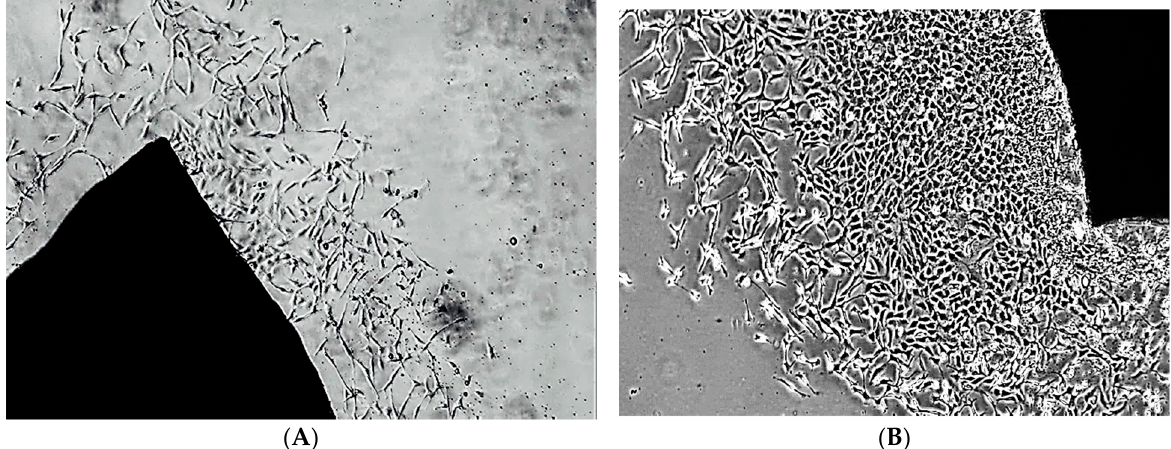
Figure A1. In vitro culture of rat aortic VSMCs from aortic explants viewed at 160× magnification (10× E-PL, 4× objective lens, 40× image magnification) under an inverted Olympus light microscope. ( A ) Cell growth after 4 days incubation; ( B ) cell growth after 7 days incubation (scale bar: 27.2851 µM). Figure A2 is a visual presentation of the stained rat aortic VSMCs depicting the presence of SM22 α actin fibers.